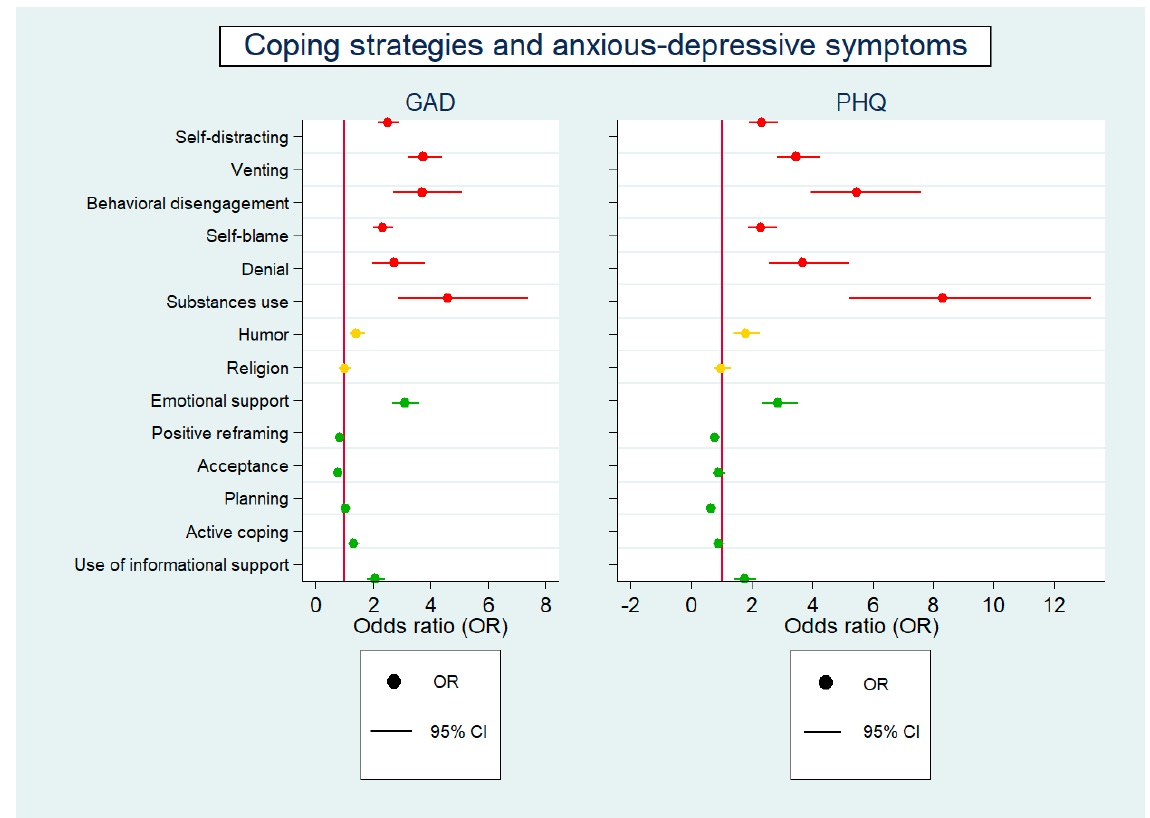
Figure 2. Logistic regression of anxiety and depressive symptoms as predicted by coping styles. Two models are presented for anxiety and depressive symptoms indexed as having reached the GAD − 7 and PHQ − 9 cut-off values, respectively. Avoidant coping subscales are plotted in red, active coping subscales in green, and neither active nor avoidant in yellow. The odds ratio (OR) indicates the effect size and is reported with 95% confidence intervals (CI). The reference line of odds ratio (OR = 1) is cranberry colored.